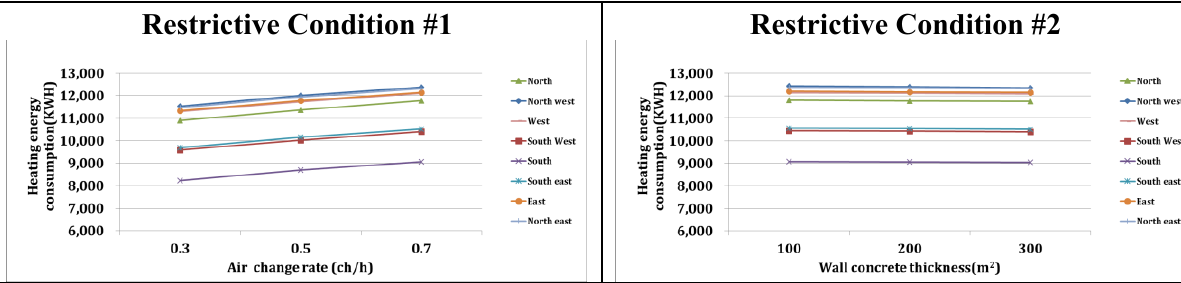
Table 7. Restrictive condition tests for verifying solar radiation